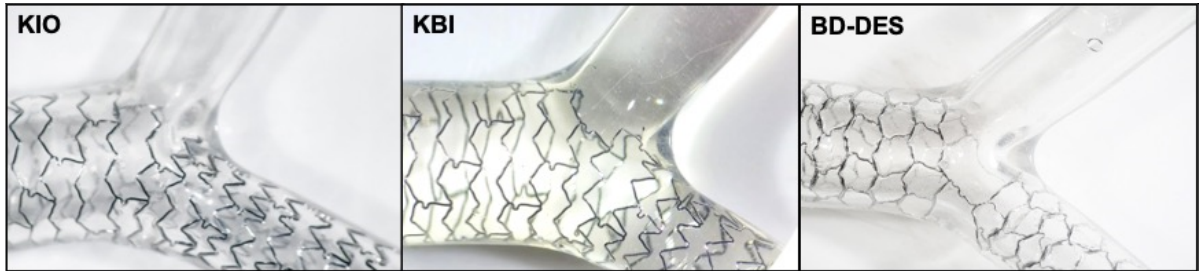
Figure 1. Optical images of platforms implanted into a model of bifurcation. According to clinical measurements of the angle between the left anterior Deployment of DES into bifurcation model at NP (Proximal=5.5mm, Distal=3.5 mm, SB=3.5 mm)